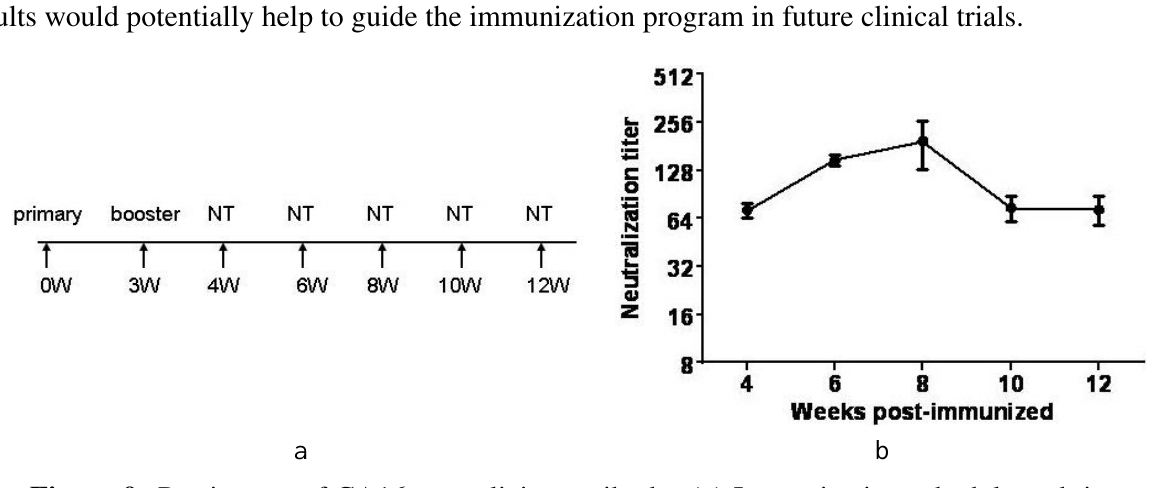
Figure 9. Persistence of CA16 neutralizing antibody. ( a ) Immunization schedule and time points for testing of neutralizing antibody titers; ( b ) CA16 whole virus specific antibody responses were analyzed by measuring neutralizing antibody titers at the 4th, 6th, 8th, 10th and 12th week after primary immunization. Neutralization titers (Y-axis) are plotted on a logarithmic scale.